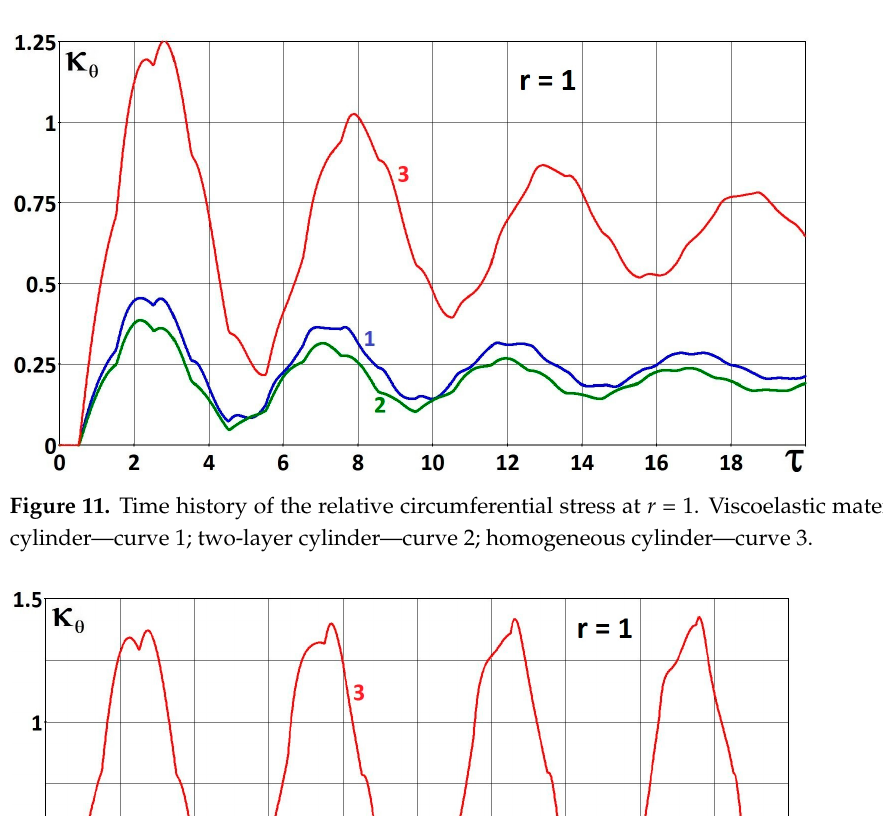
Figure 14. Time history of the relative radial stress at r = 0.75. Elastic materials. FGM cylinder— curve 1; two-layer cylinder—curve 2; homogeneous cylinder—curve 3. The presented results in Figures 9–14 demonstrate the influence on the considered nonstationary wave process of both the inhomogeneity of the material and its viscoelastic properties. As for the case of a layer composed of FGM (Section 4), in the case of a hollow cylin- der of the FGM, the viscosity practically does not have time to manifest itself within the relatively short times after the moment the first perturbation front arrives at the consid- ered observation point. However, in contrast to the elastic FGM, in the viscoelastic FGM, the wave process gradually decays. For the external load, used in this study, the relative stresses ( , ) r r κ ( , ) r θ κ